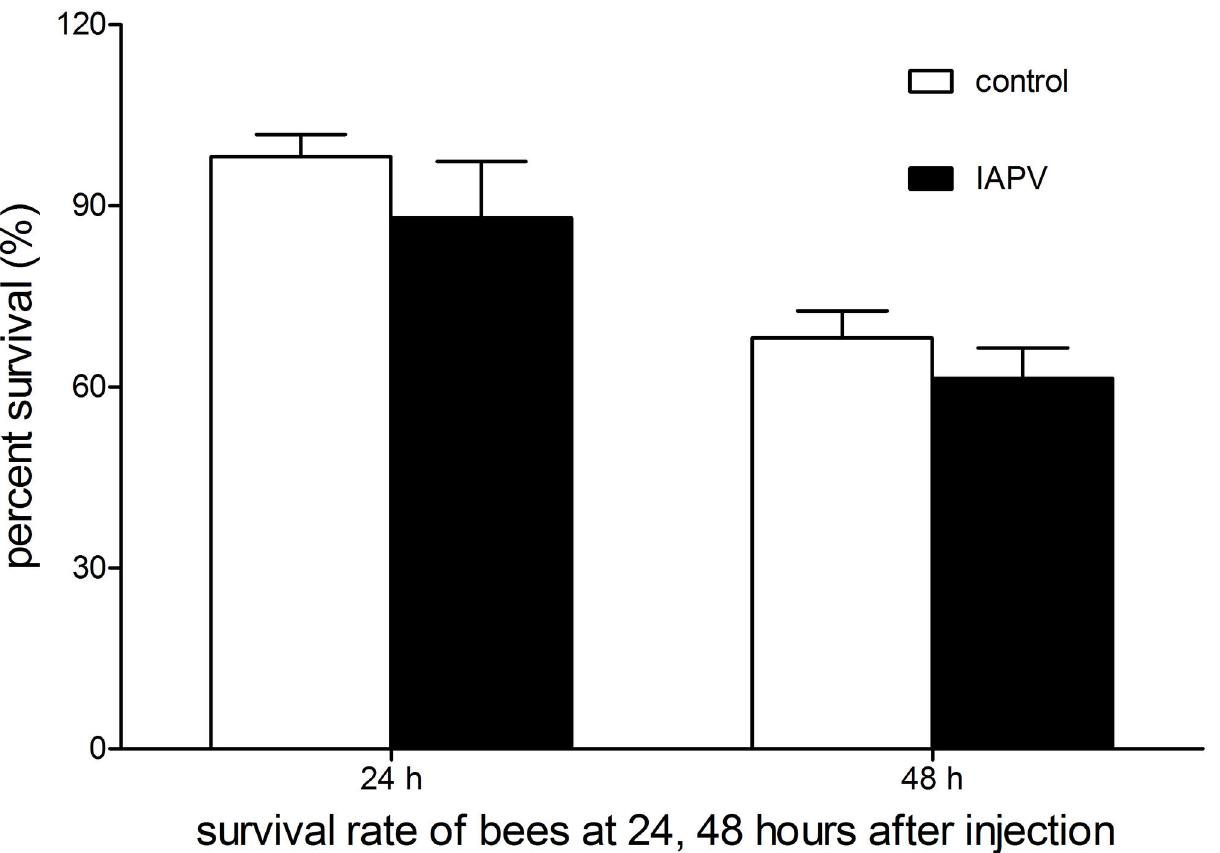
Figure 3. Analysis of survival rates. Comparison of survival rates between honey bees injected with IAPV and honey bees of the control groups at 24, 48 hours after injection. The data are expressed as mean ± SD of four independent experiments. doi: